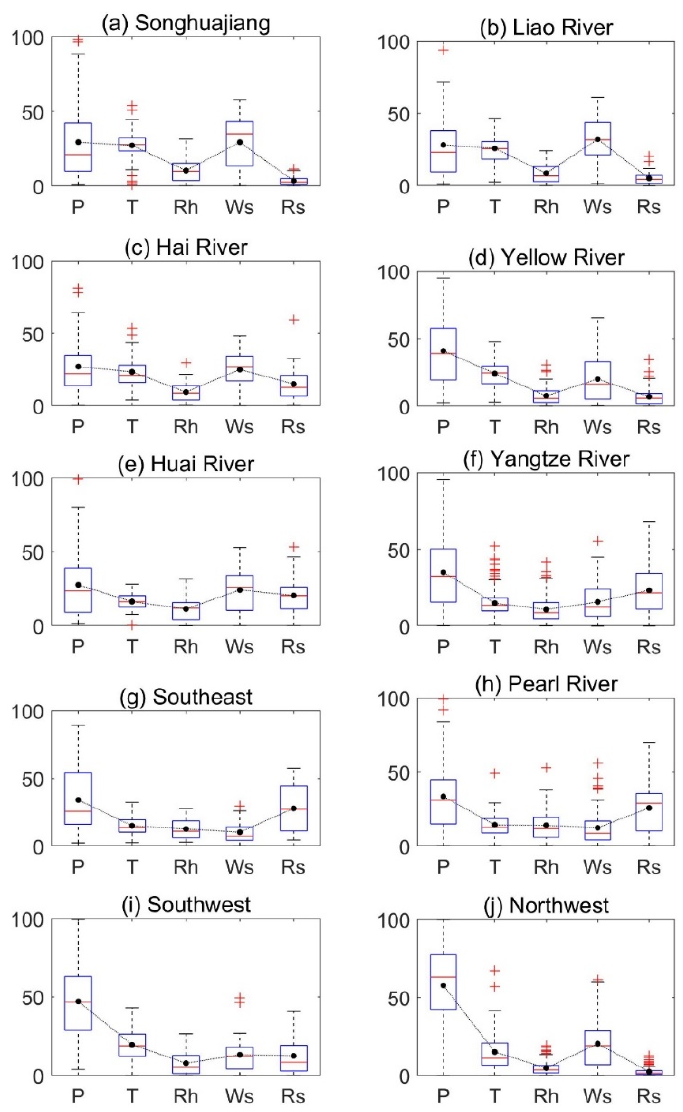
Figure 8. Relative contributions (%) of climatic drivers to the changes in aridity from 1961–1988 to 1989–2016 in the ten basins. The contributors are denoted by P (precipitation), Tmax (maximum temperature), Tmin (minimum temperature), Rh (relative humidity), Ws (wind speed), and Rs (radiation) on the x axis. The vertical spread of the box–whisker plots shows the variations in relative contribution among climate stations within each basin. The boxes cover the ranges from the 25% quartile to the 75% quartile of the distributions, with the median values marked by red lines within each box and outliers marked by plus signs. The mean contributions of each factor are marked with black circles.